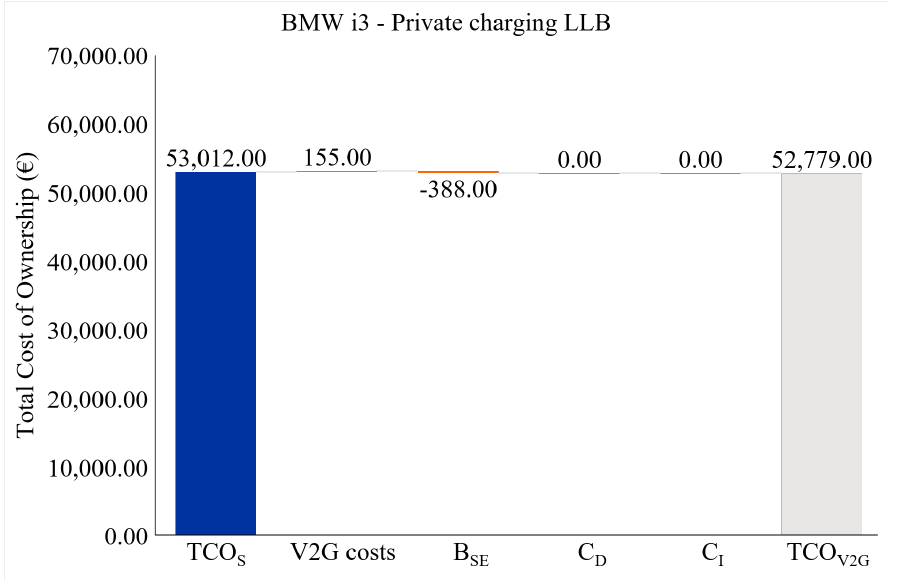
Figure A13. Standard and V2G TCO of a BMW i3 in a private charging case providing LLB ( TCO S = Standard TCO, B SE = benefit of saved electricity costs from the grid, C D = direct com- pensation, C I = indirect compensation, TCO V 2 G = V2G TCO); source: own